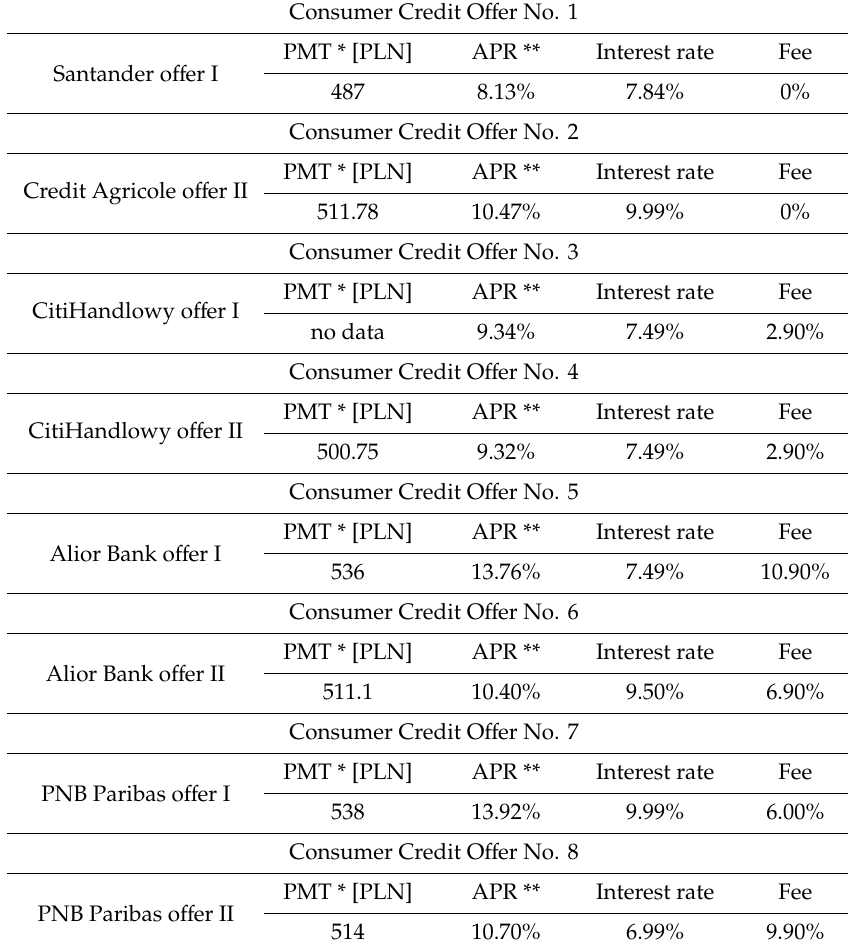
Table 1. Actual consumer credit o ff ers: eight examples. Terms of credit: amount of credit: 20,000 PLN, 48 monthly repayments (Constant